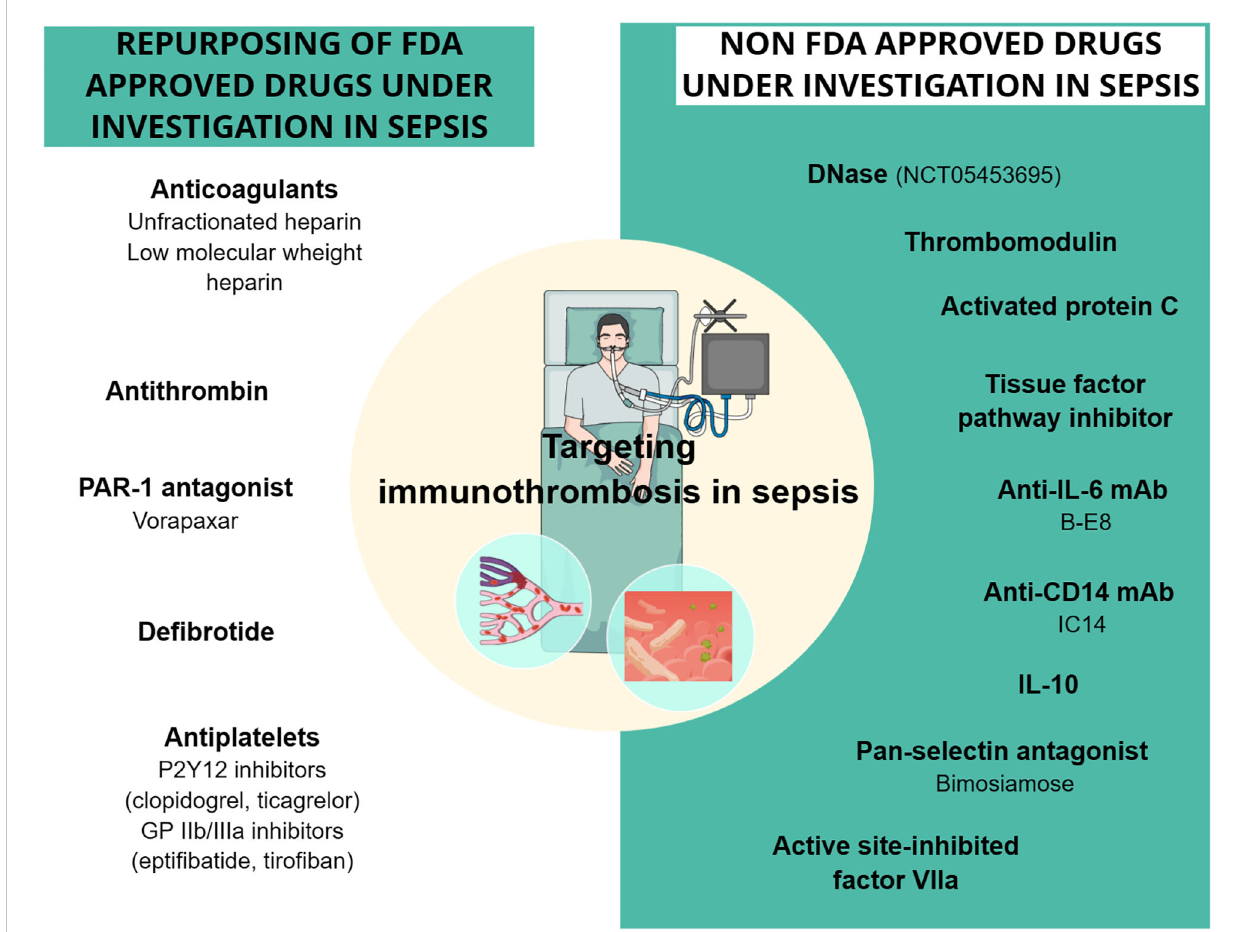
FIGURE 3 Drugs targeting sepsis-related immunothrombosis in clinical trials. Both FDA-approved and unapproved drugs have been studied in clinical trials for their effect on sepsis-related immunothrombosis. The drugs depicted in the fi gure showed con fl icting results regarding their effect on mortality rates and coagulation parameters in sepsis patients. DNase is the only one with no clinical results yet, as the phase 1 study (NCT05453695) using DNase intervention has recently started. CD14, cluster of differentiation 14; DNase, deoxyribonuclease; GPIIb/IIIa, glycoprotein IIb/IIIa; IL, interleukin; mAb, monoclonal antibody; PAR-1, protease-activated